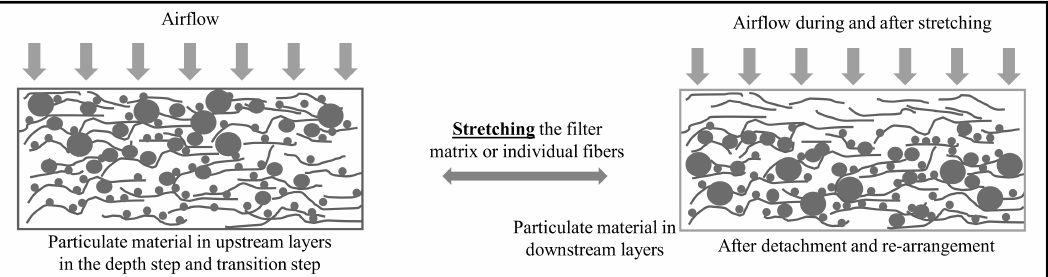
Figure 1. Schematic of the filter matrix, in a cross section. LEFT: Normal mass accumulation matrix during the first (depth filter step) and the second filter step (transition step). Ref. [4] RIGHT: Potential distribution of particulate material after detachment and re-arrangement of particles within the filter matrix. Fiber stretching was used to initiate detachment to clear up some void space. Modified from VDI 3677